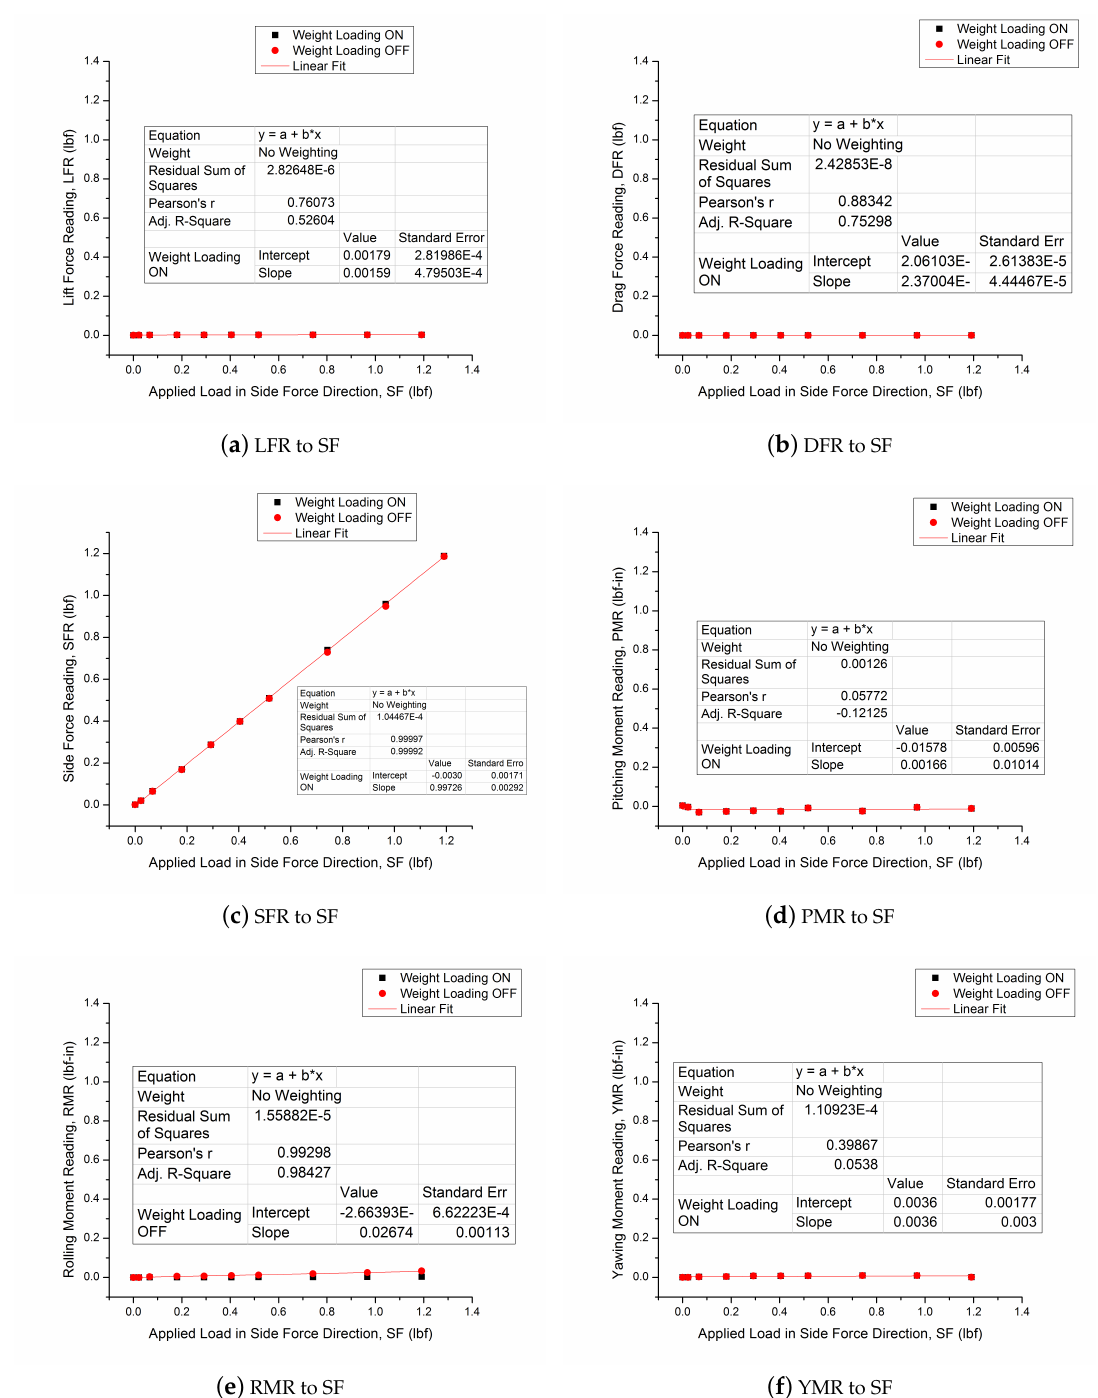
Figure A3. Experimentally obtained wind tunnel pyramidal balance interactions upon applied load in side force